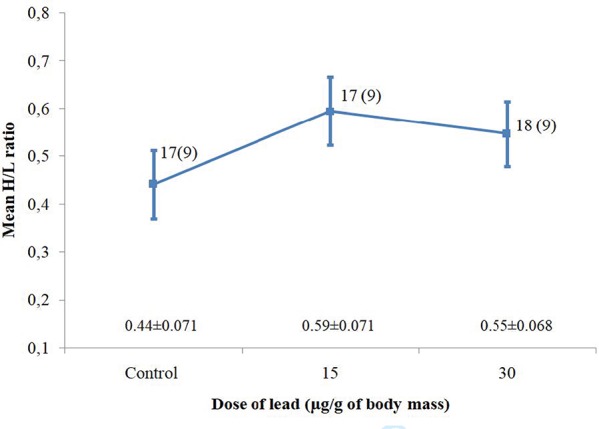
Mean H/L ratio variation of great tit nestlings that were experimentally supplemented with lead acetate solution in comparison with control individuals. Mean ± standard errors calculated from the linear mixed model are shown. Sample sizes are shown as the number of nestlings and, in parentheses, as the number of broods